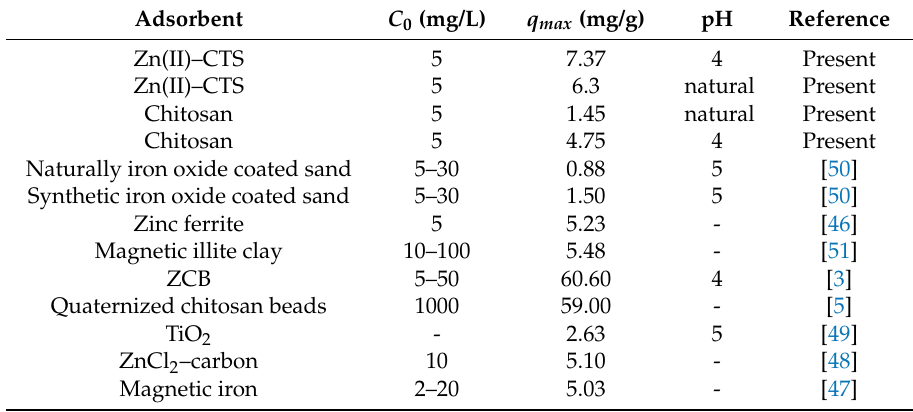
Table 5. Phosphate adsorption on different engineered